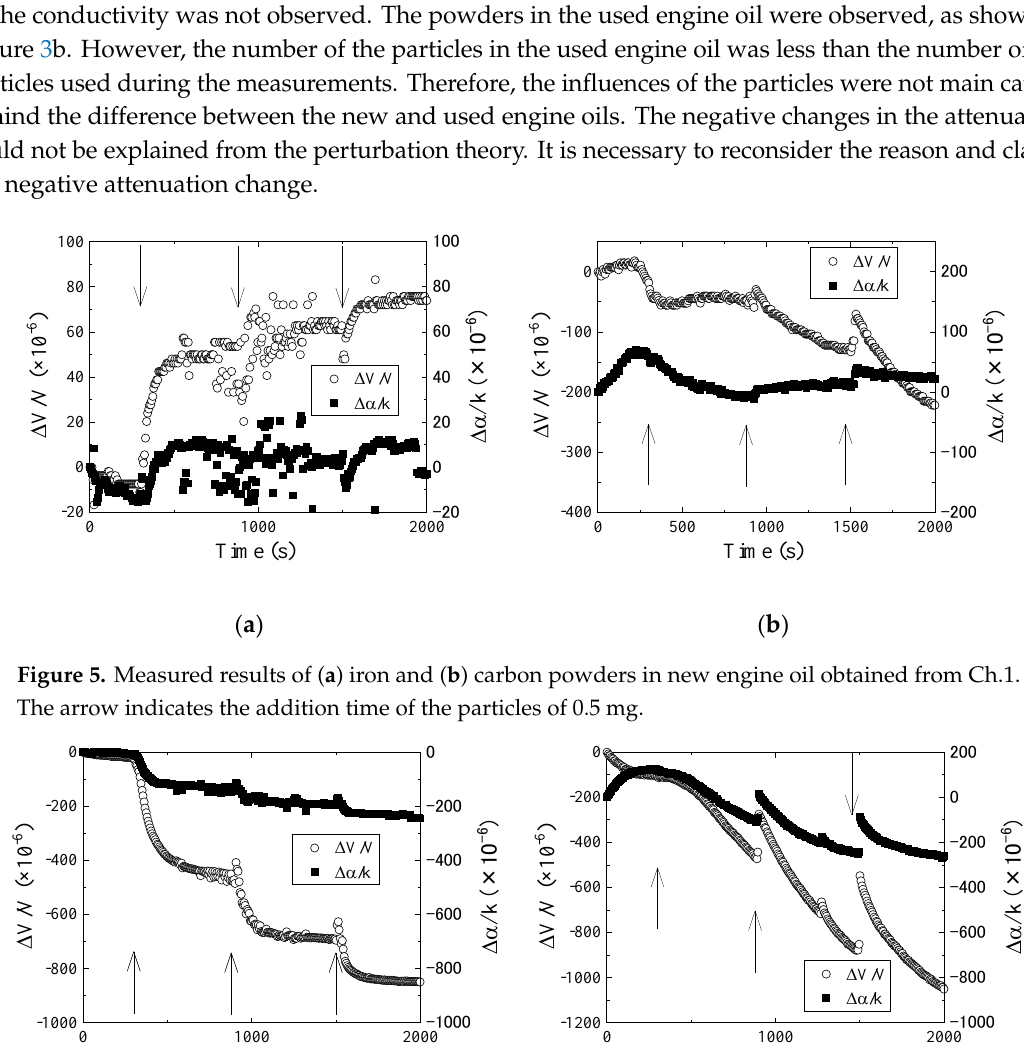
Figure 5. Measured results of ( a ) iron and ( b ) carbon powders in new engine oil obtained from Ch. 1. The arrow indicates the addition time of the particles of 0.5 mg.